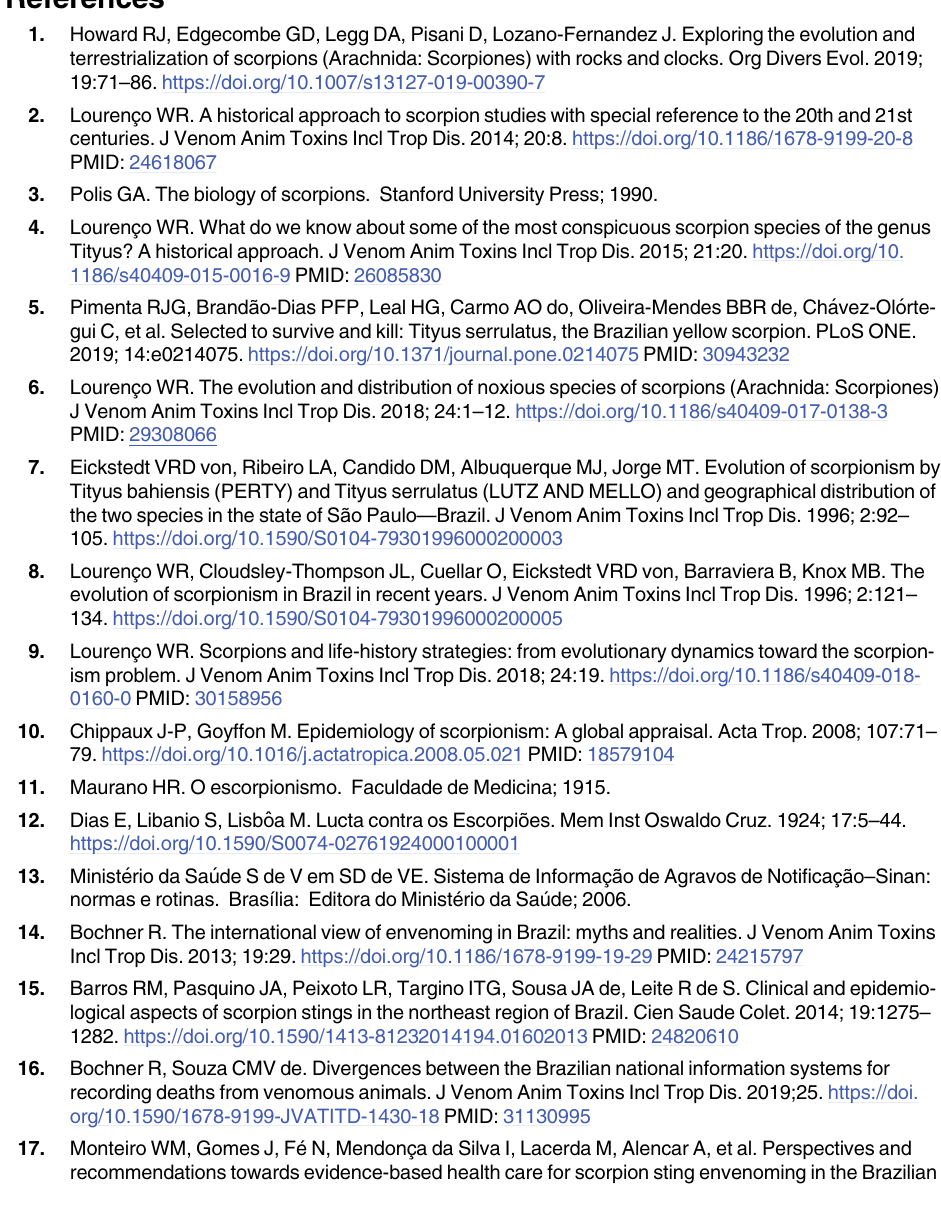
S1 Table. Table containing epidemiological data obtained from SINAN (Sistema de Infor- to the different aspects of reported scorpion accidents in Brazil are analyzed in the different table’s